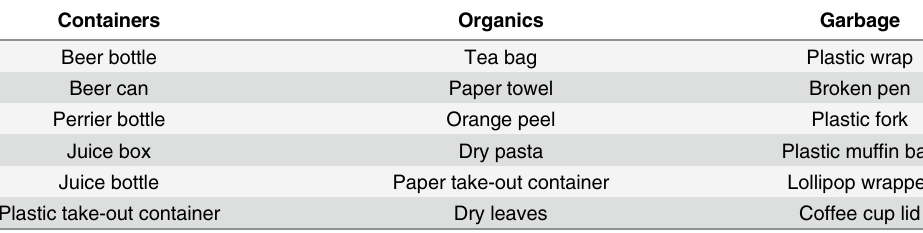
Table 1. List of items in each waste